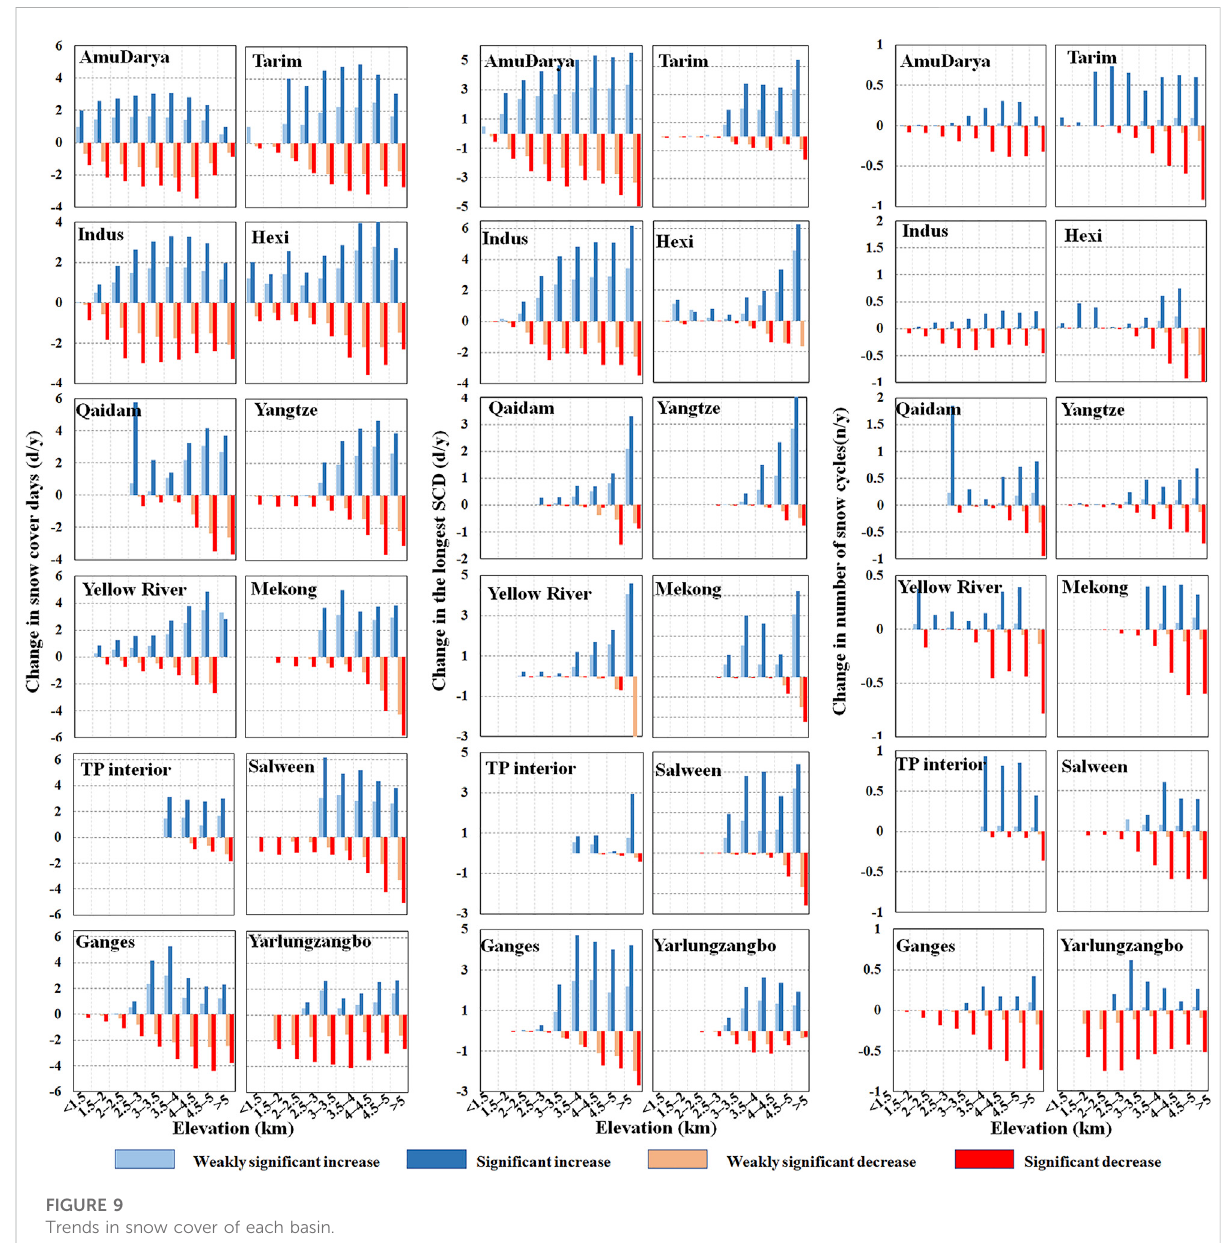
FIGURE 9 Trends in snow cover of each